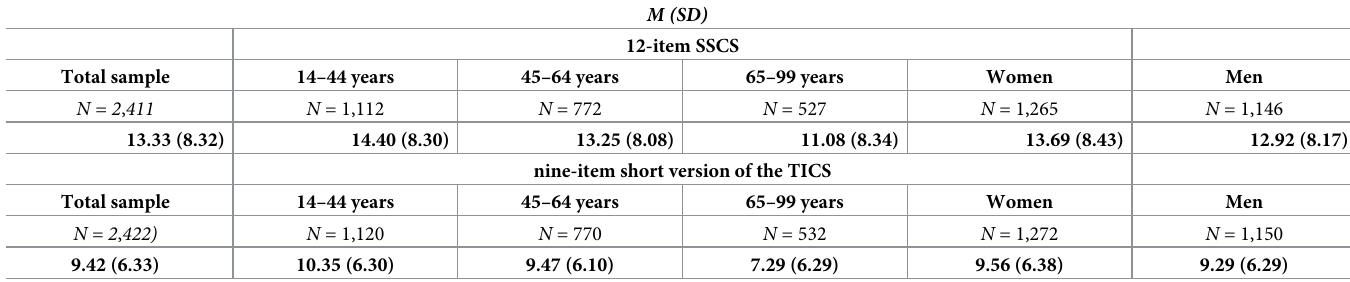
Table 2. The 12-item SSCS and the new nine-item short version of the TICS and their properties for different age cohorts and for gender.